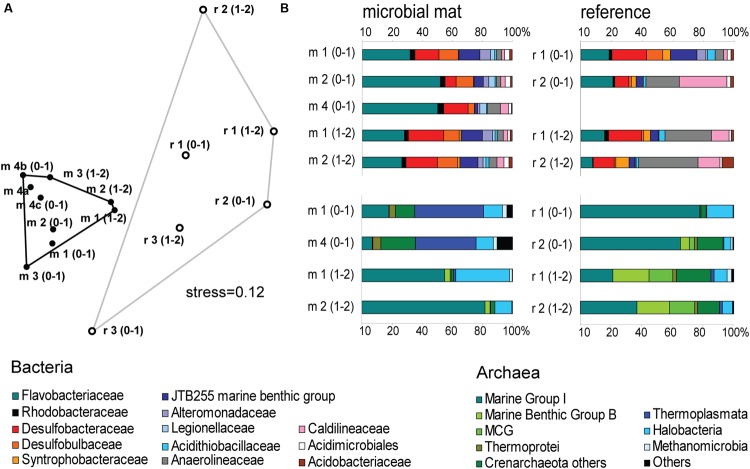
(A) Nonmetric Multi Dimensional Scaling (NMDS) ordination plot based on Bray–Curtis distance matrix from ARISA profiles. Convex hulls depict significant differences between groups of mat-covered sediments (black circles) and references sites (white circles). Bonferroni corrected P-value < 0.001; Analysis of Similarity (ANOSIM) based on Bray–Curtis R-value = 0.7. (B) Relative abundance of bacterial (above) and archaeal (below) sequences from the upper 2 cm (0–1 and 1–2 cm horizons) obtained by 454-MPTS comparing mat-covered sediments (left) and references sites (right). MCG-Miscellaneous Crenarchaeotal Group.